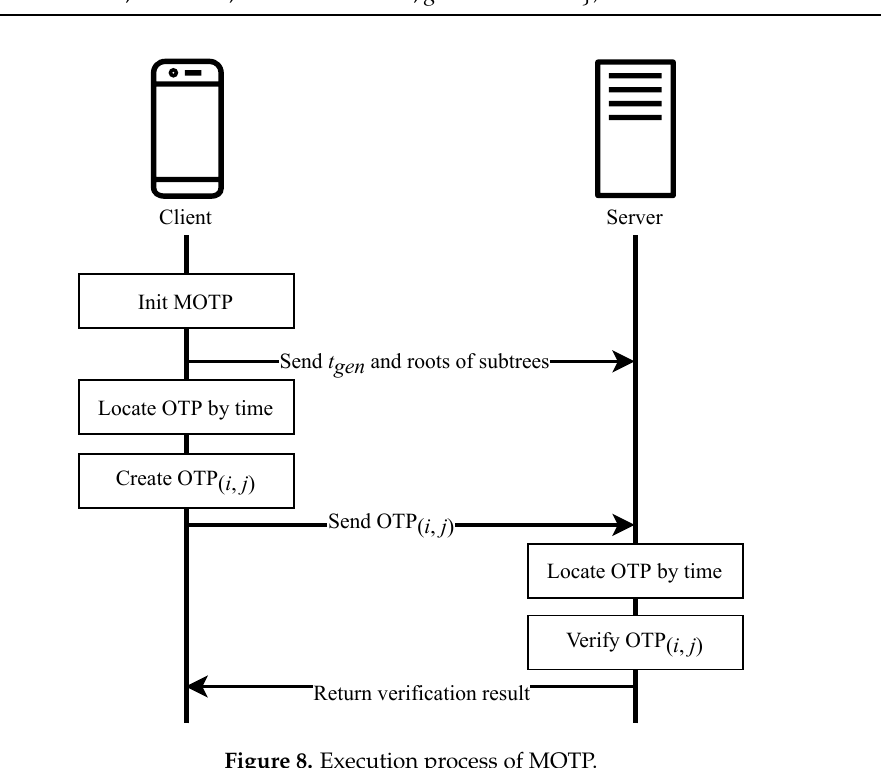
Figure 8. Execution process of